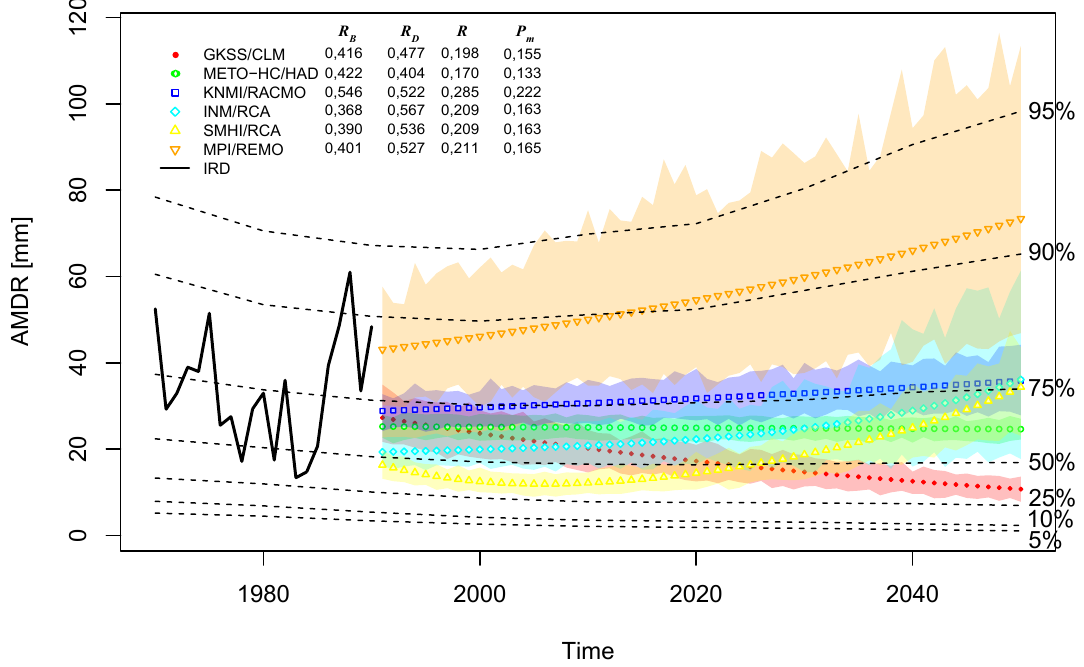
Fig. 4. PDF ensemble on site 16. The dashed lines show 5 to 95% quantiles of PDF ensemble, and markers represent the RCM mean values obtained from the fitted PDF. The polygons show the mean variability in the period 1991–2050, using the 95% CI computed with bootstrapping. The IRD AMDR series in 1970–1990 is presented as a solid line. The computed REA values ( R B , R D , R and Pm ) used to build the PDF ensemble, are